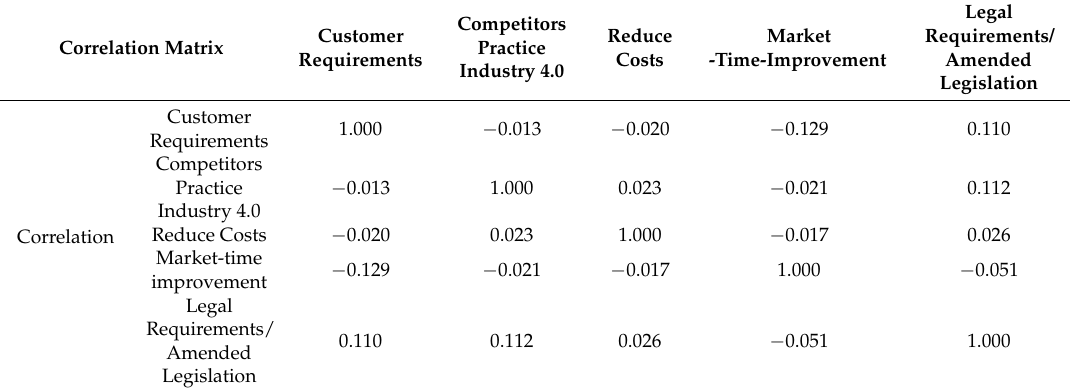
Table 6. Correlation coefficient matrix of the 5 analyzed variables.